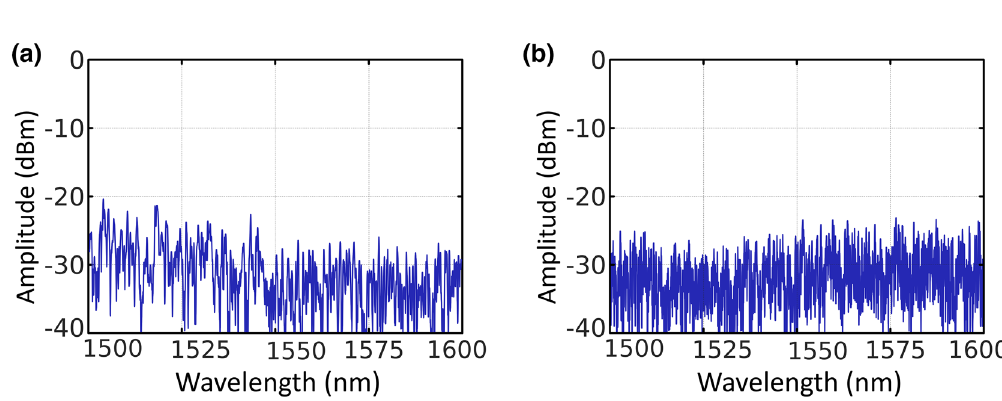
Figure 4. Output spectra of a short-linear-cavity fiber laser when using a single mode MDF pumped by a 976- nm laser at 140 mW.